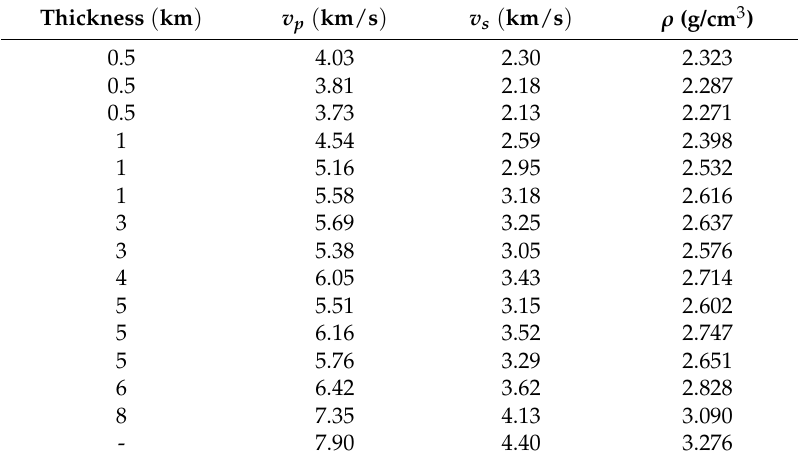
Table 2. Crustal velocity